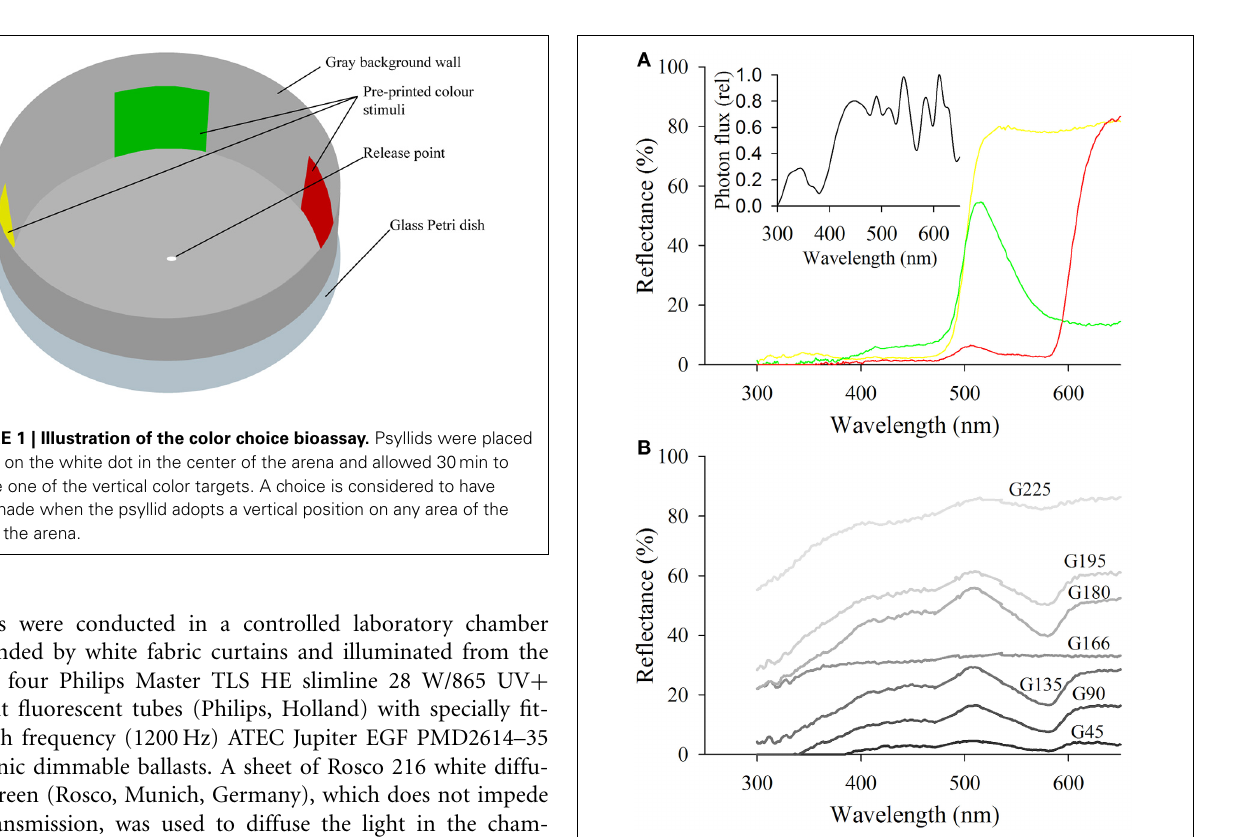
FIGURE 2 | Reflectance spectra of the different targets used as stimuli. (A) Shows targets corresponding to the green, yellow, and red targets used to assess preferences of psyllids for chromatic stimuli. The insert represents the irradiance spectrum of the lighting in the arena. (B) Represents the spectra of the different shades of gray employed to determine psyllids’ attraction to achromatic stimuli. Note the spectrum of G166 corresponding to the gray used as the background color in all